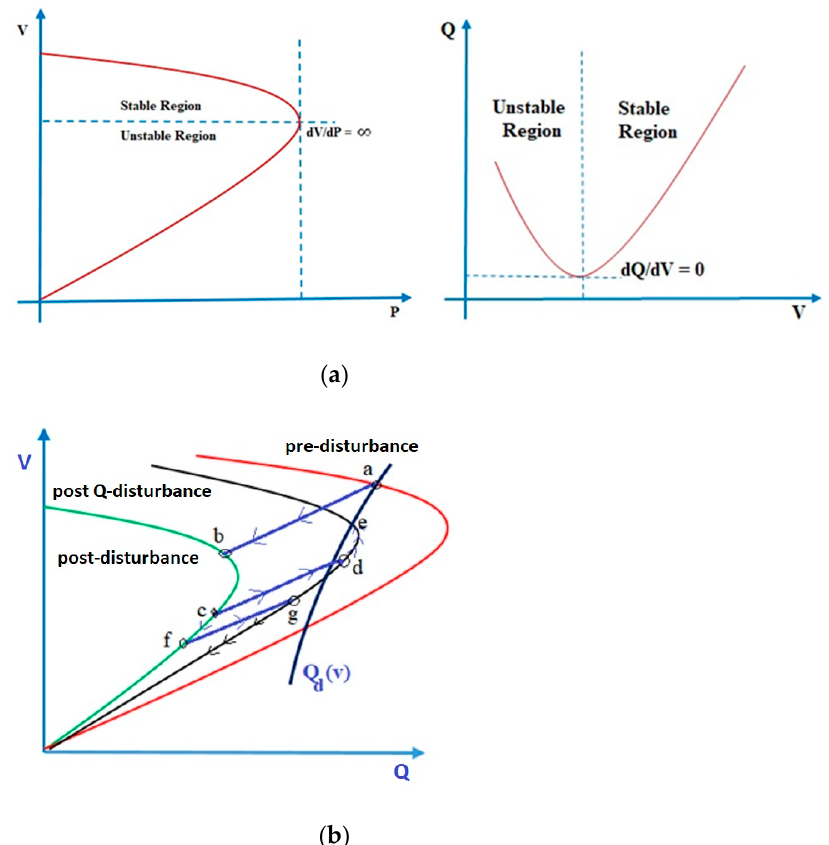
Figure 6. ( a ) P-V and Q-V Characteristics, ( b ) Q-V characteristics for pre-and post- disturbances